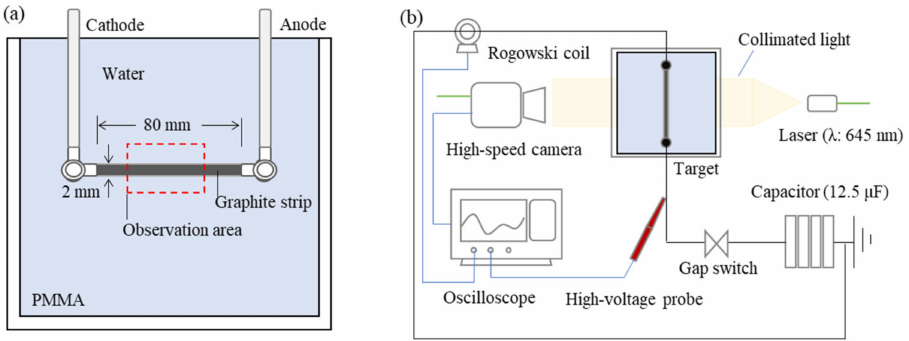
Figure 1. Schematic illustration of the high-speed observation experiment: ( a ) Details of observation target; ( b ) Electrical circuit, instrumentation connections, and the shadowgraph optical observa- tion